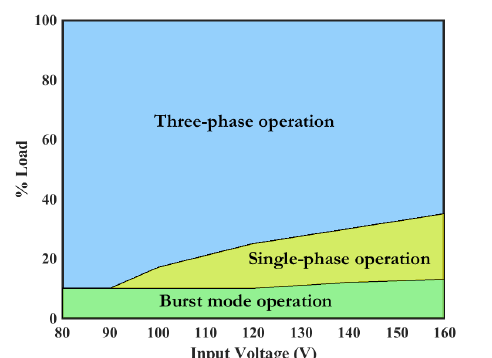
Figure 15. Region of operation for the proposed modes.